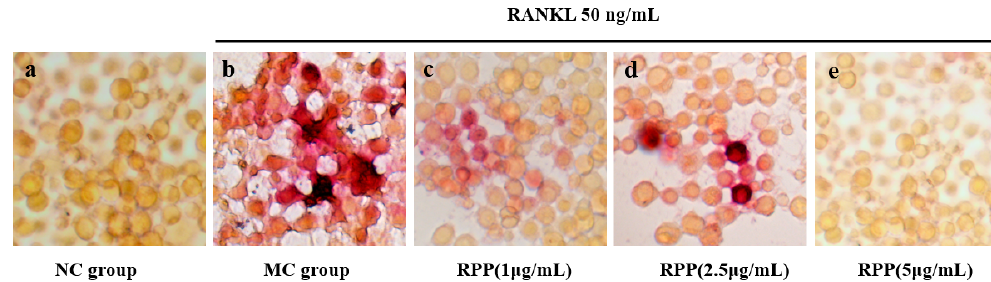
Figure 2. E ff ects of RPP on receptor activator nuclear factor-kappa B ligand (RANKL)-induced di ff erentiation of RAW264.7 cells into osteoclastcells. ( a ) Normal control (NC) group; ( b ) model group (MC) (RANKL); ( c ) RPP-L (RANKL, 1 µ g / mL RPP); ( d ) RPP-M (RANKL, 2.5 µ g / mL RPP); ( e ) RPP-H (RANKL, 5 µ g / mL RPP). The cells were stained for tartrate-resistant acid phosphatase (TRAP) and the magnification was 400 ×